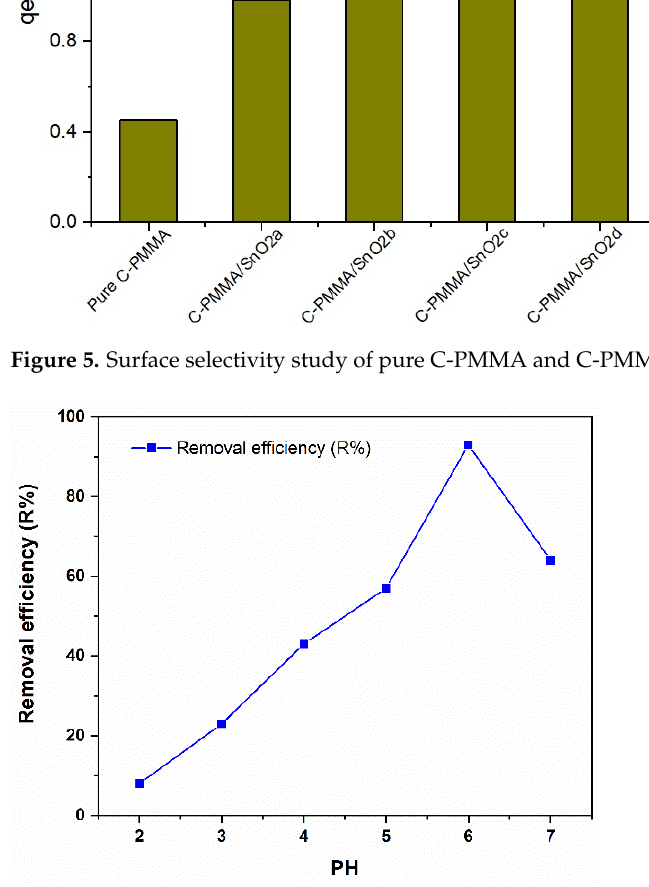
Figure 6. The effect of pH on the adsorption of Cr (III) (5 mg/L) on 20 mg of C-PMMA/SnO 2 c at 25 °C.